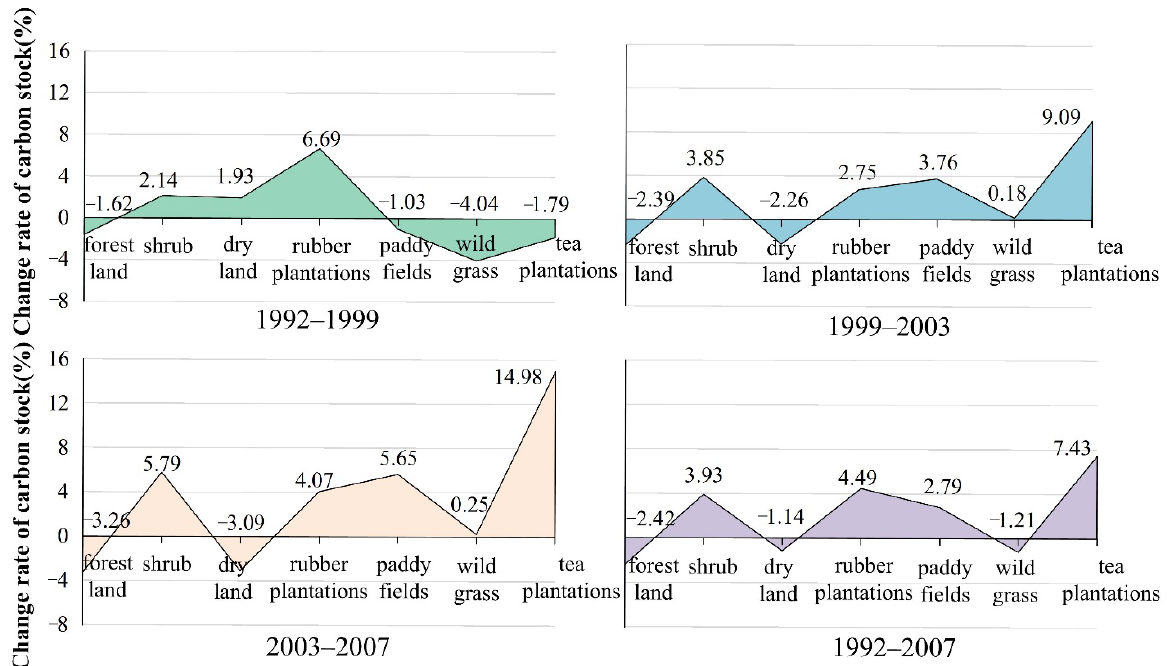
Figure 4. Change rate of carbon stocks in